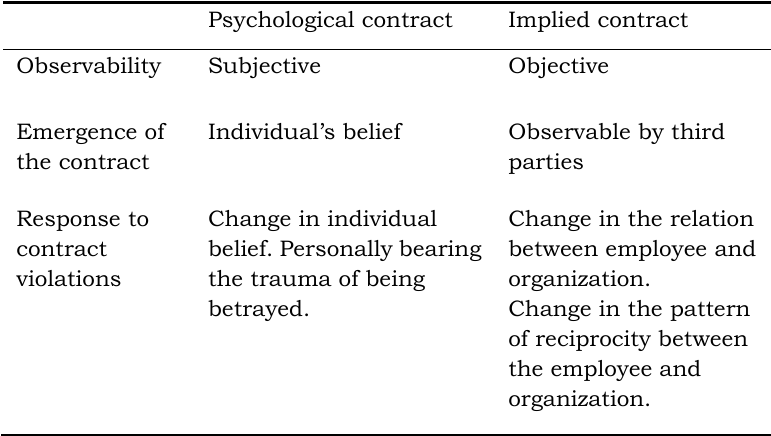
Table 1. Comparison of the psychological contract and the implied